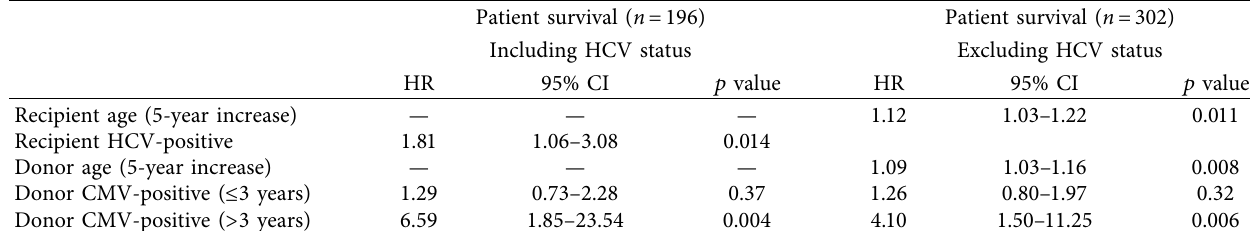
Table 5: Multivariable analysis after backward stepwise selection of predictors for patient survival in